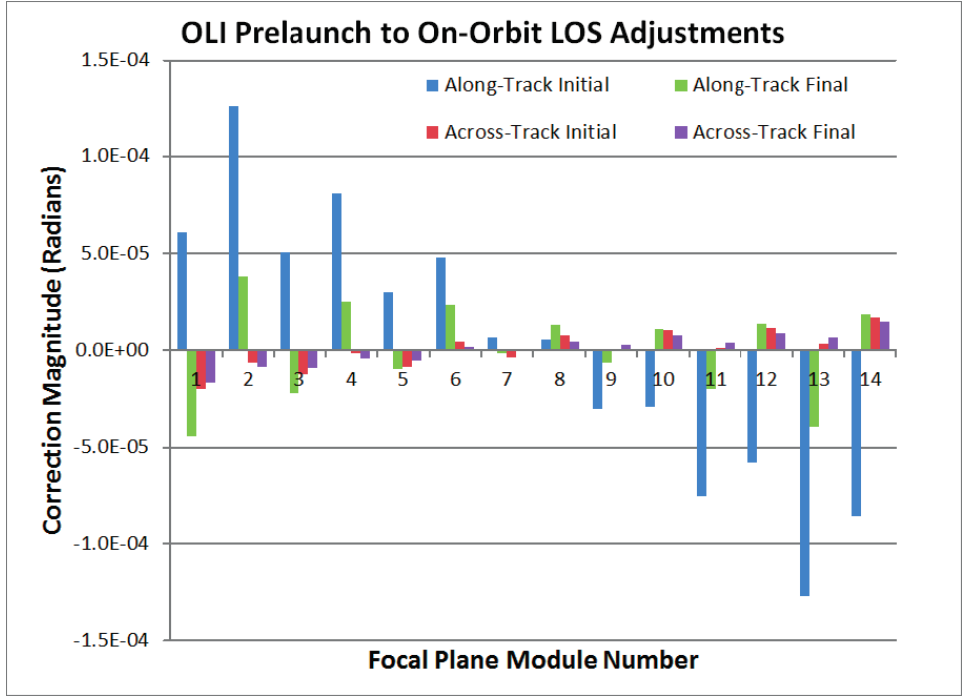
Figure 6. On-orbit FPM-to-FPM alignment corrections before (blue and red bars) and after (green and purple bars) the OLI-to-spacecraft yaw alignment was